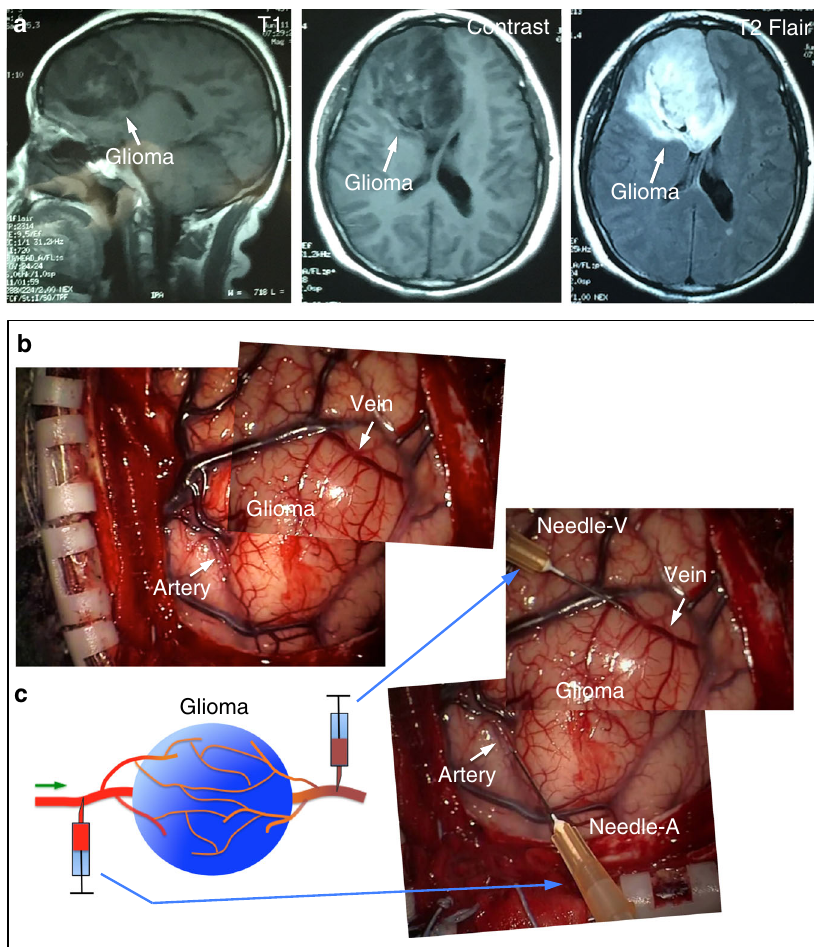
Fig. 1 The method of blood sample collection from patient glioma arteries and veins. a MR imaging of brain tumors in patients. The representative images were collected from a patient with a 3.0 T scanner. T2-weighted/ fl uid attenuated inversion recovery (FLAIR) axial images and postcontrast T1-weighted images were acquired to identify the location of the glioma. b , c Our strategy for collecting samples of blood from a glioma artery and vein for paired comparison. Left panel, schematic showing the method of glioma blood collection; right panel, combined images showing the locations where blood samples were collected from a patient ’ s glioma. The combined image was generated from two images taken at different time